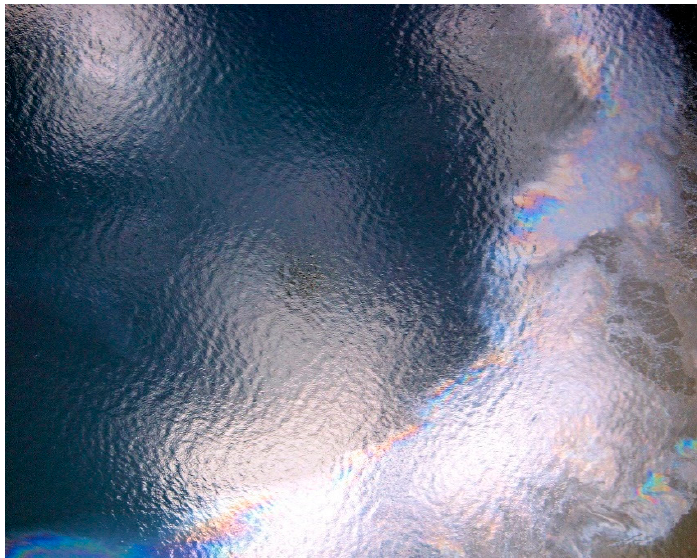
Figure 2. A photograph of a rainbow sheen taken from an aircraft at an altitude of about 300 m. This color of sheen has a strong physical relation to 1 to 1.5 µm.